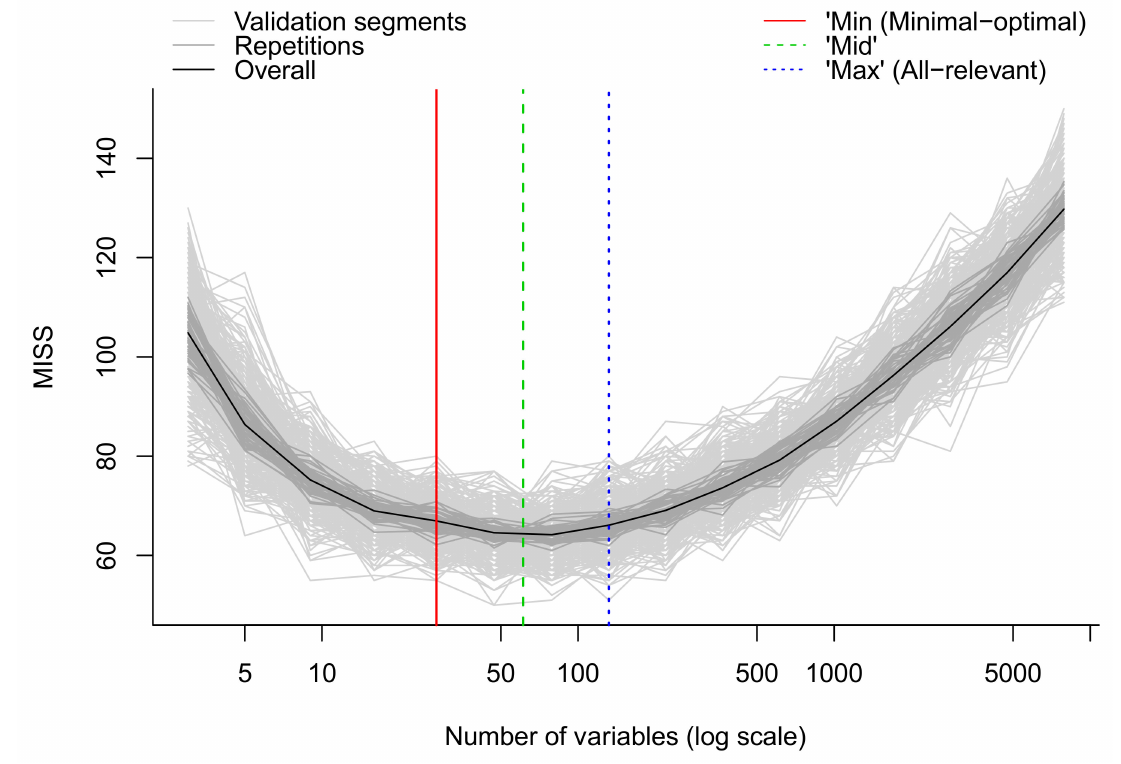
Figure 13. Modelling error measured as the number of miss-classification during internal cross-validation in MUVR. The overall modelling error (black curve) initially decreases when removing noisy variables until the ‘max’ model. Further removal of variables until the ‘min’ model removes redundant features while keeping modeling error almost constant. The ‘mid’ model represents a compromise between the ‘min’ and ‘max’ models and a theoretical optimum model. Light and dark grey lines represent higher level of detail in the validation procedure and we refer to Shi et al. [50] for